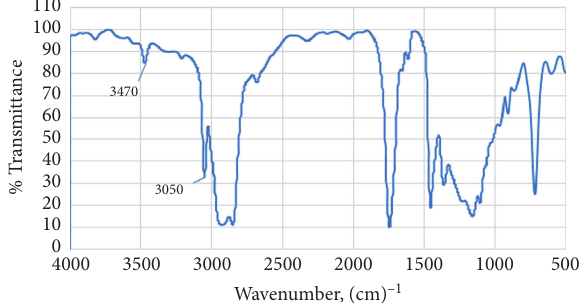
Figure 19: FTIR spectra of chaulmoogra